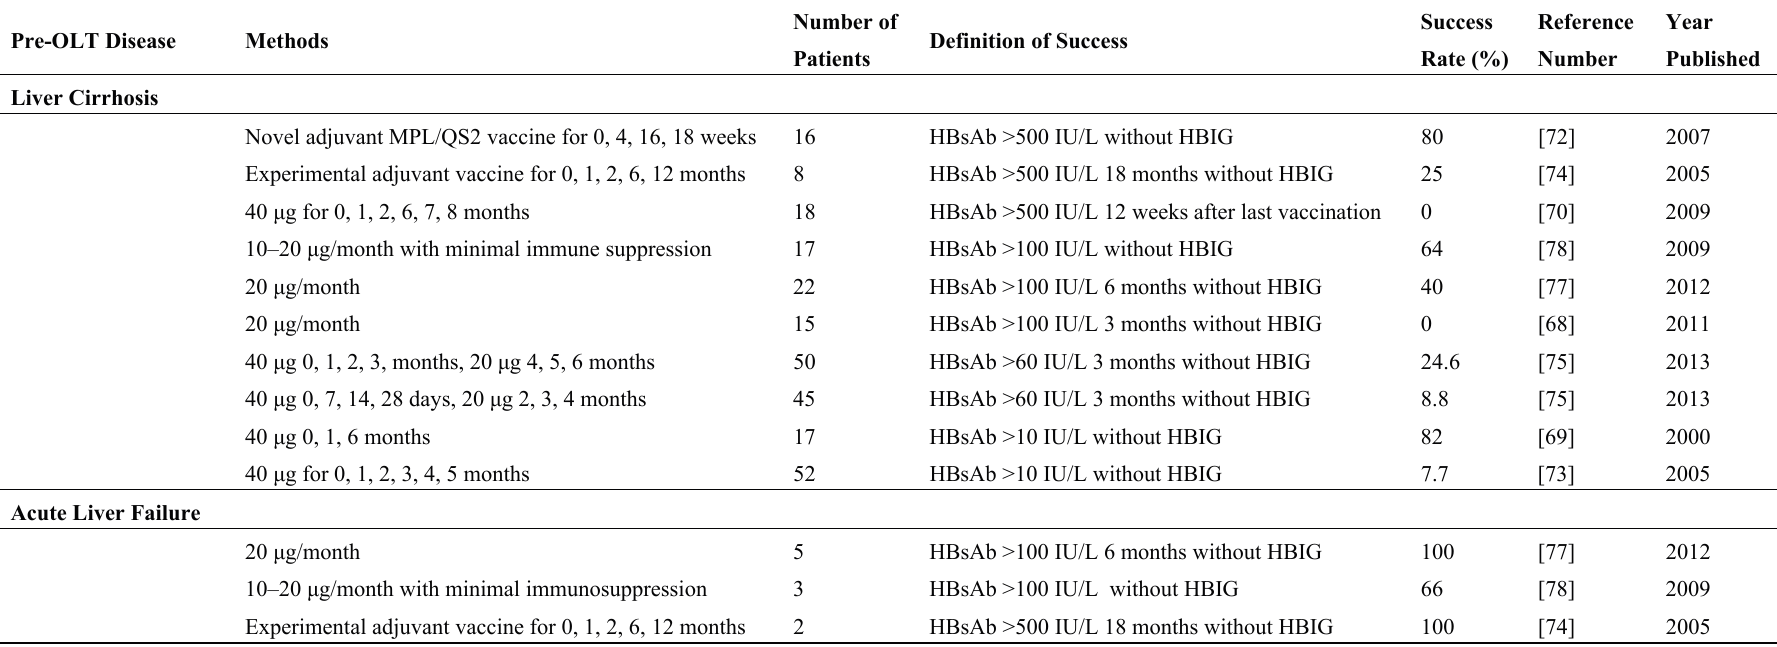
Table 2. Representative Post-OLT HBV-Vaccine